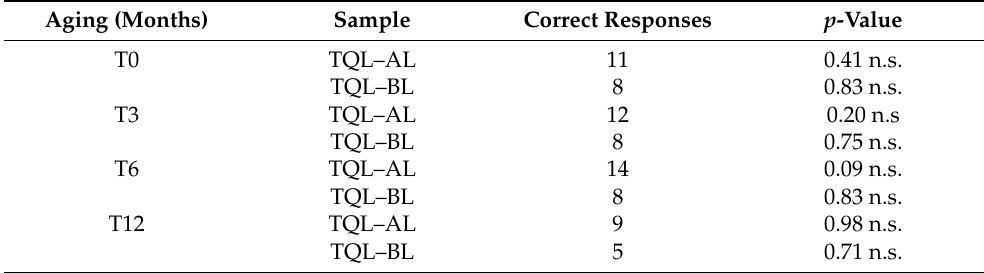
Table 4. Triangle method results for the pairs of Sangiovese wine samples analyzed at 0, 3, 6 and 12 months of aging. Aging (Months) Sample Correct Responses p